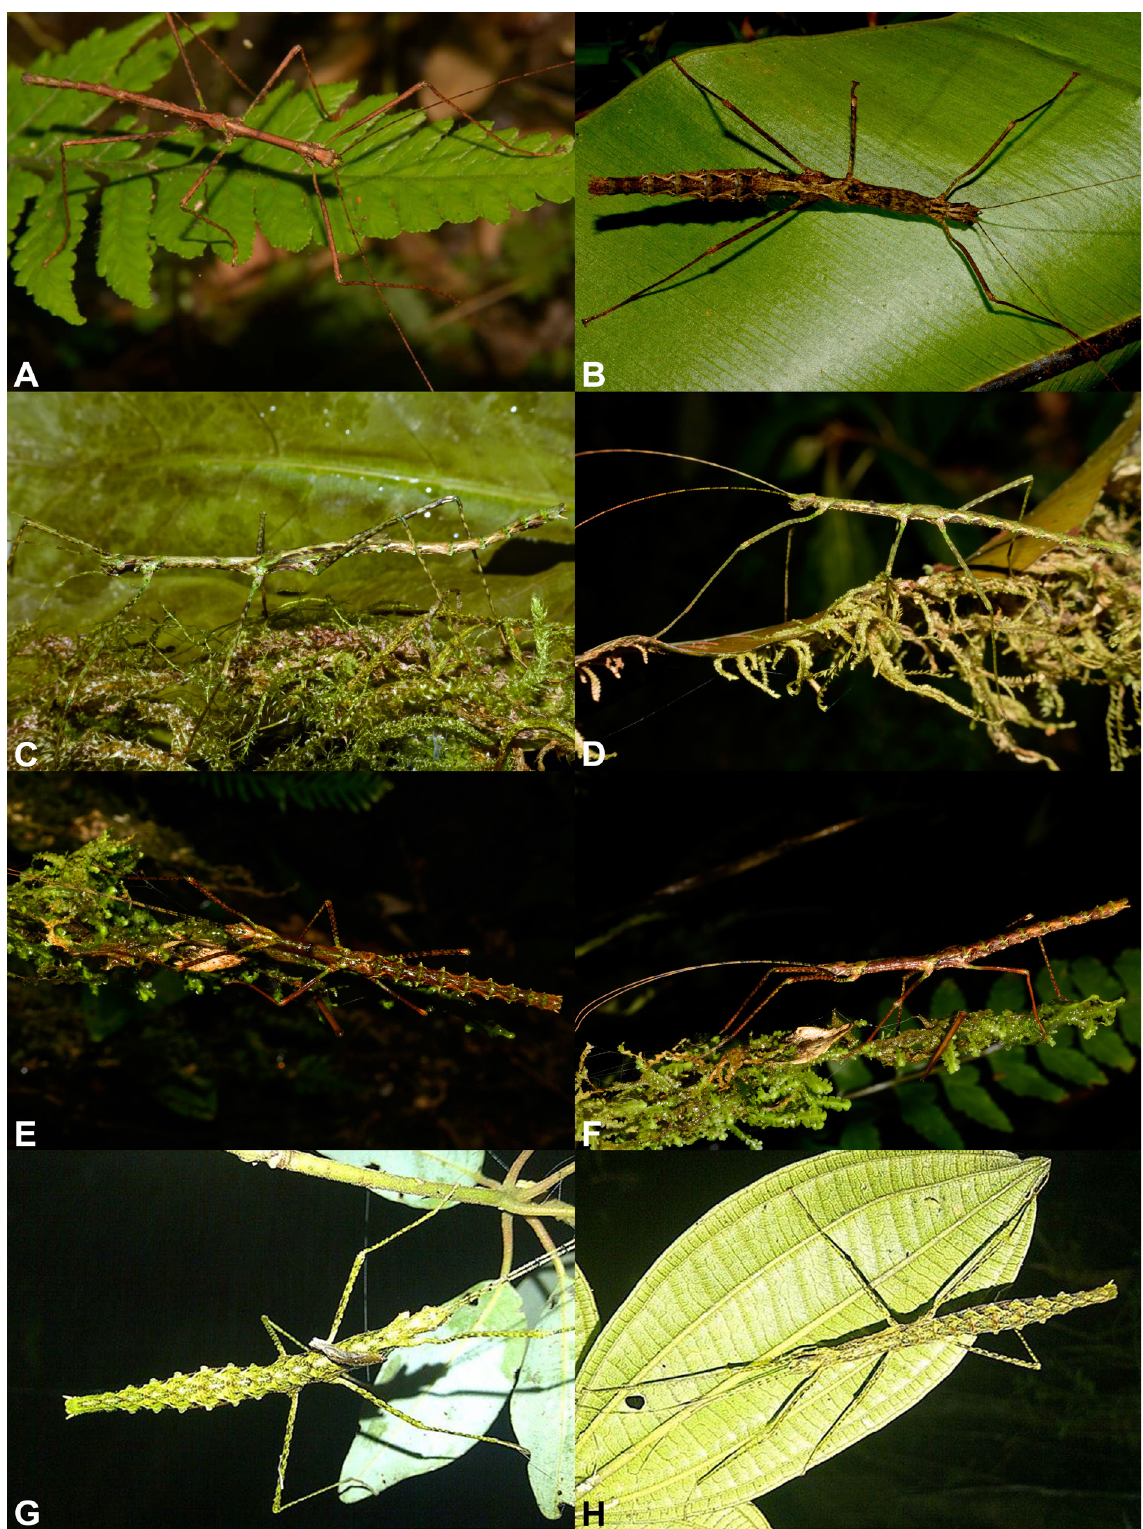
Fig. 10. Otraleus spp., photographs in natura . — A–F . O. christianae sp. nov. A . ♂, 16 Nov.